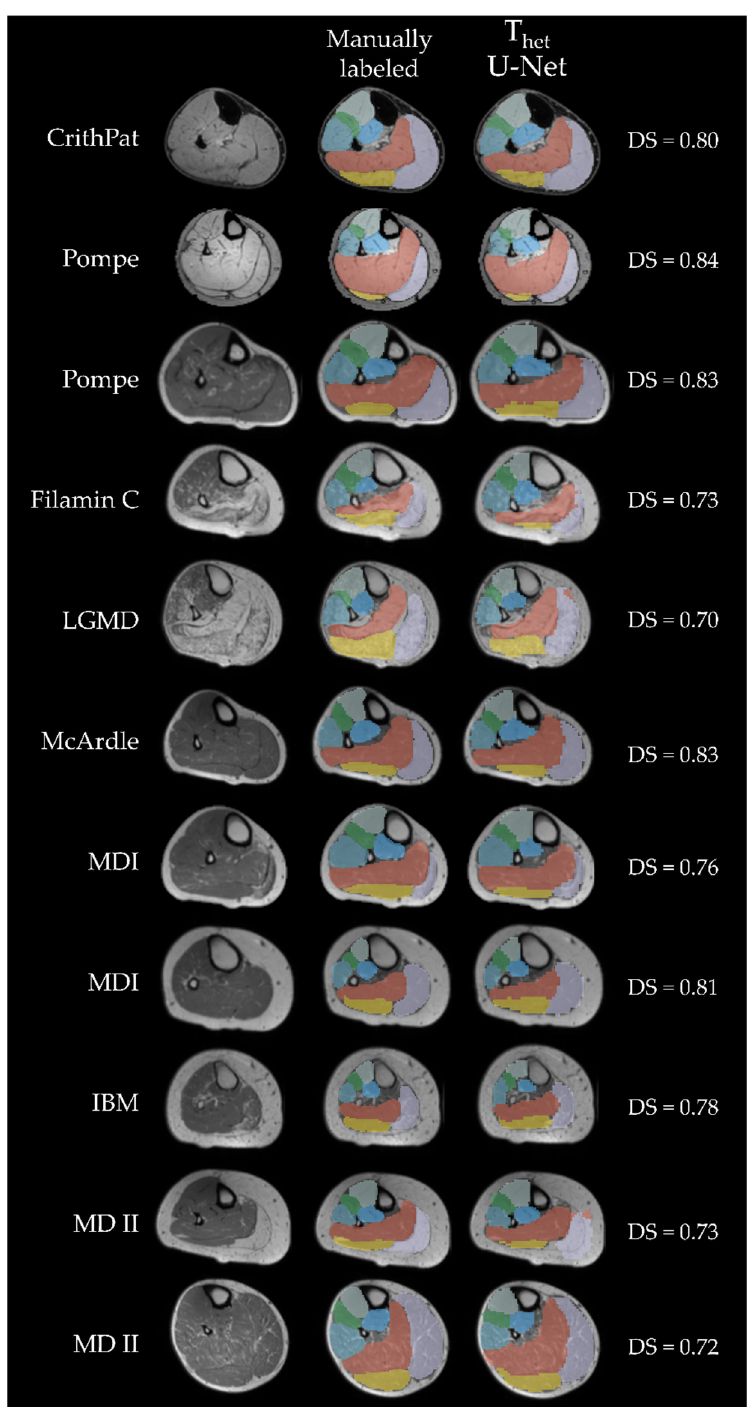
Figure 6. All cross-sectional patient MR-images included in P het . Each column displays a patient, while each row shows the MR image, manual segmentation and U-Net predicted label, respectively. The first two rows show Dixon-weighted-images from data acquisition (B), all others are T1 weighted images from data acquisition (A). Labels are displayed with transparency to see underly- ing boundaries. Green = extensor digitorum longus (EDL); purple = gastrocnemius lateralis (GL); yellow = gastrocnemius medialis (GM); light blue = peroneal group (PER); orange = soleus (SOL); mint = tibialis anterior (TA); blue = tibialis posterior (TP); CrithPat = critical illness polyneuropathy; Pompe = Morbus Pompe; Filamin C = filamin C myopathy; LGMD = leg-girdle muscular dystrophy; MDI = myotonic dystrophy type 1; IBM = inclusion-body myositis; MDII = myotonic dystrophy type